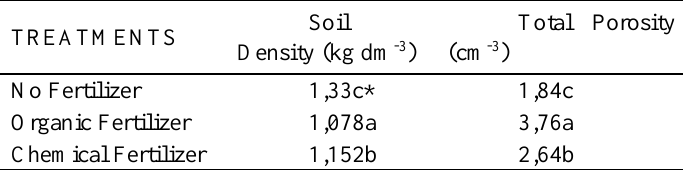
Table 3: Density and porosity of the soil after application of three treatments analyzed during the six months of research.